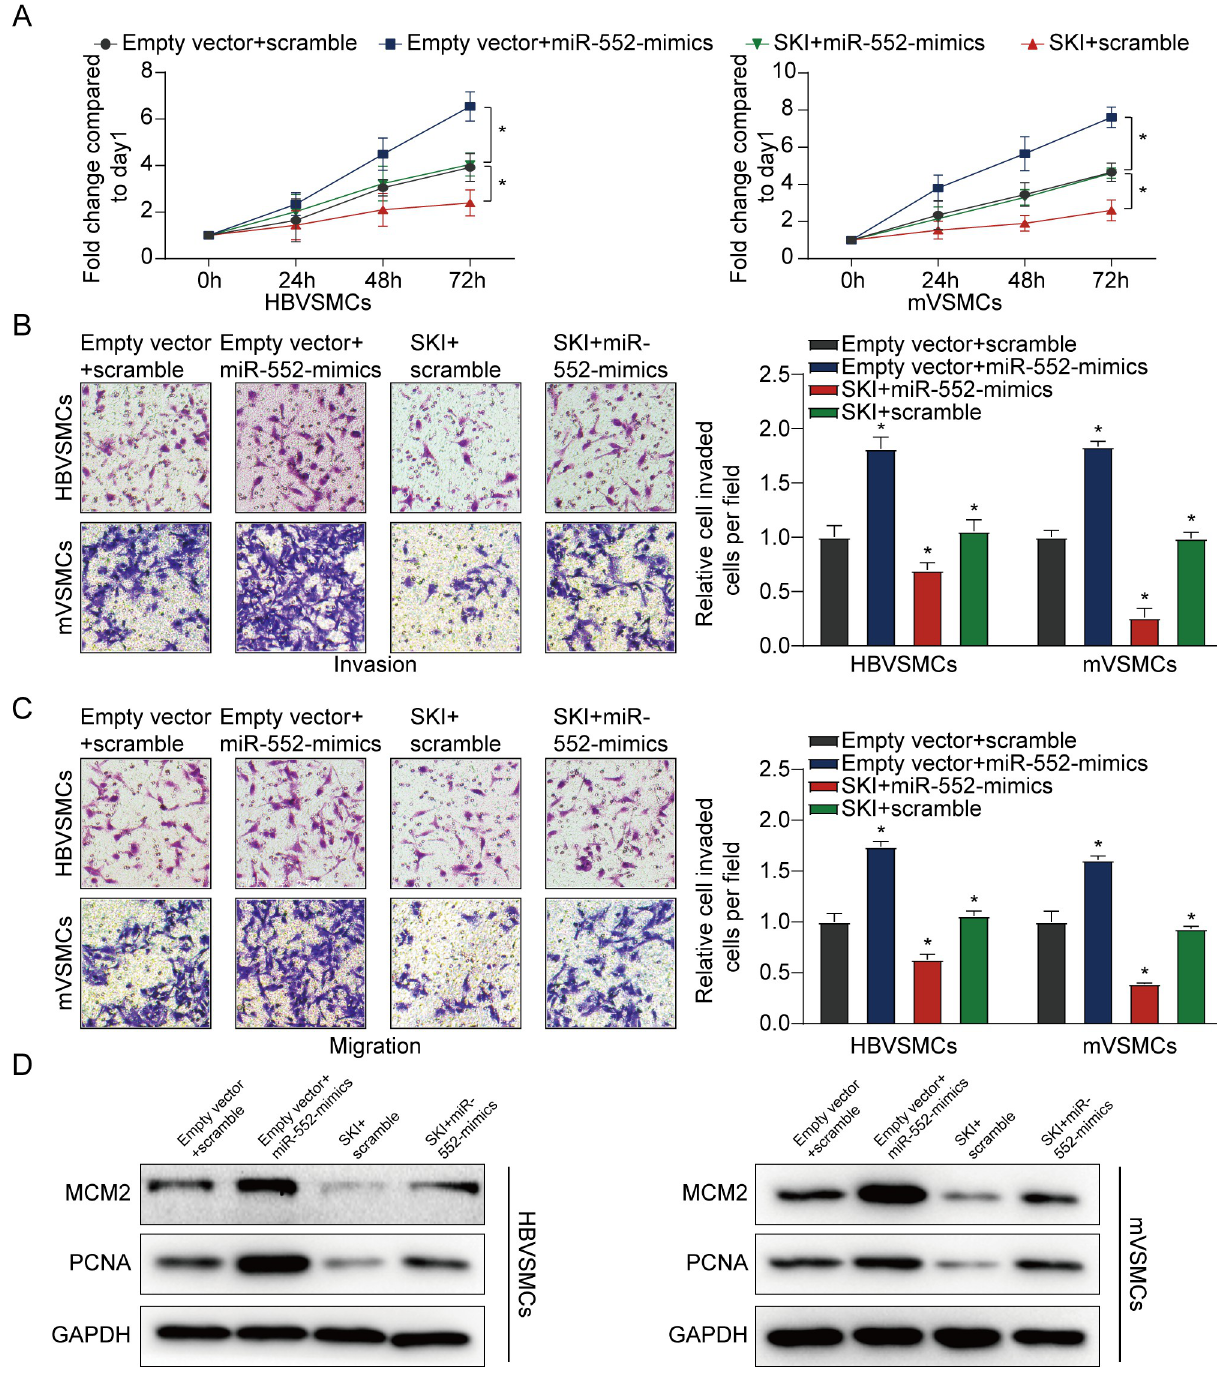
Fig 4. Restoration of SKI reverses the promoting effect of miR-552 on VSMCs. ( A ) The influence of miR-552 and SKI on the proliferation of HBVSMCs and mVSMCs was detected by MTT assay. (B, C ) The effect of miR-552 and SKI on the invasion and migration of HBVSMCs and mVSMCs was measured according to transwell assay. ( D ) The effect of miR-552 and SKI on the protein level of MCM2 and PCNA in HBVSMCs and mVSMCs was assessed by western blot assay. (LSD post hoc test in conjunction with ANOVA). � P < 0.05. ns: No significance.